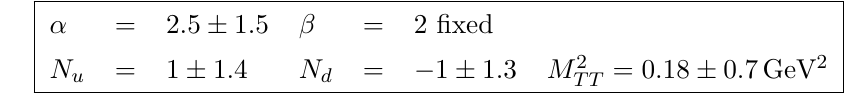
Table 5. Fitted parameters of the pretzelosity quark distributions. Table from ref.